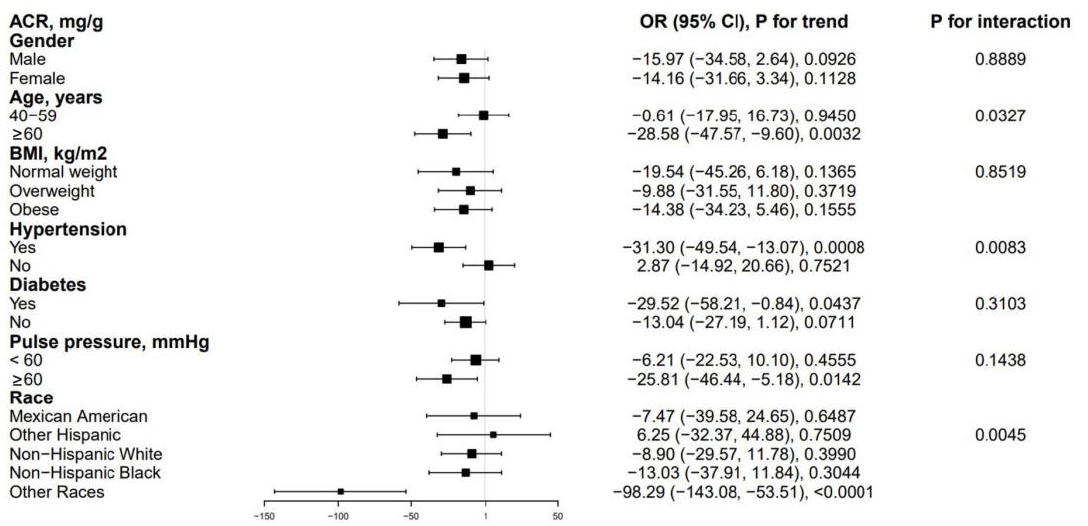
Figure 2. Subgroup analysis for the association between α -Klotho and ACR. Abbreviations: ACR = albumin–to–creatinine ratio, BMI = body mass index.